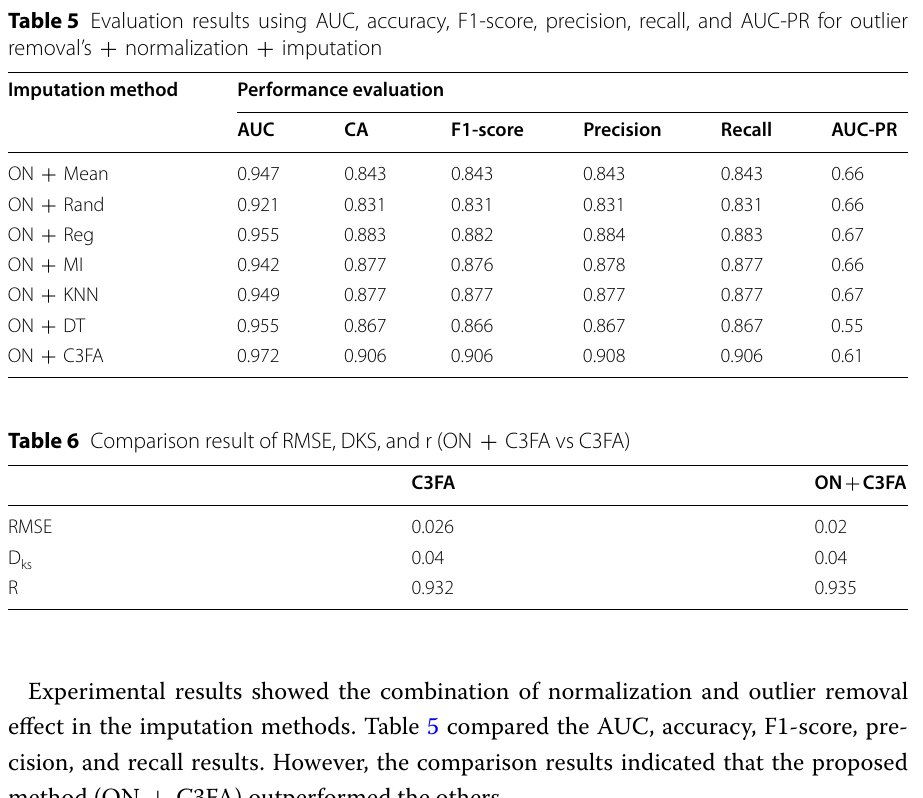
Table 5 Evaluation results using AUC, accuracy, F1-score, precision, recall, and AUC-PR for outlier removal’s normalization imputation + +